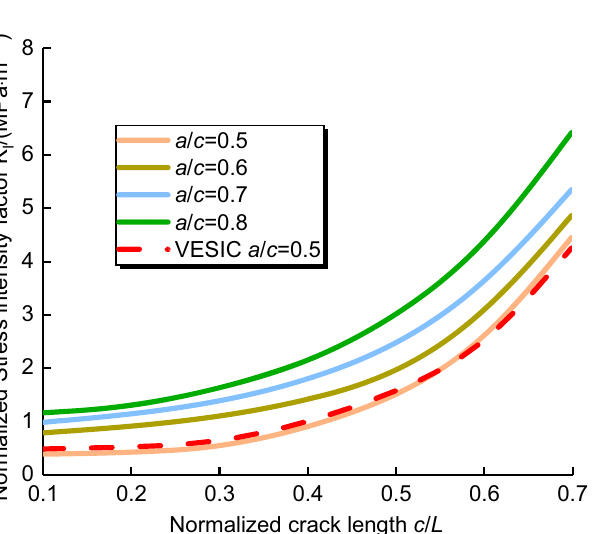
Figure 13. Relationships the normalized stress intensity factor and normalized crack length (0.2 ≤ a / t ≤ 0.5).